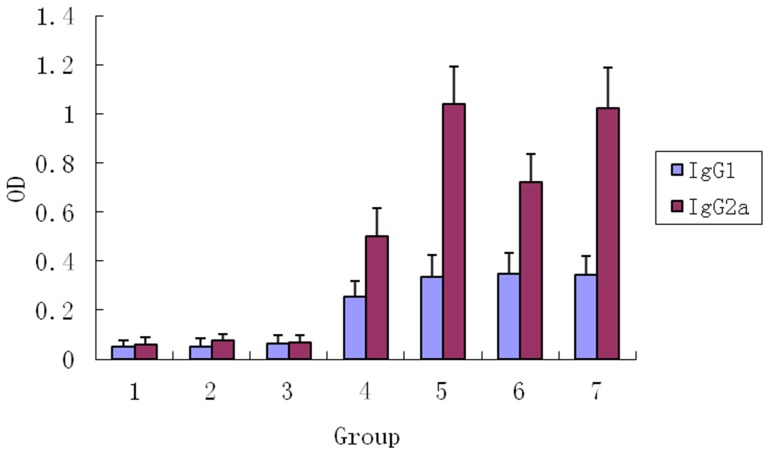
SjC23-specific IgG1 and IgG2a antibody response induced by DNA vaccines and empty vector by intramuscular (i. m) immunization.Data show the average OD values of each group with standard deviations at 1∶100 serum dilution. Statistical differences are indicated by p values. 1. Control, 2. pJW4303, 3. PAMAM-Lys, 4. pJW4303-SjC23, 5. PAMAM-Lys/pJW4303-SjC23, 6. pJW4303-SjC23-mHSP70, 7. PAMAM-Lys/pJW4303-SjC23-mHSP70.